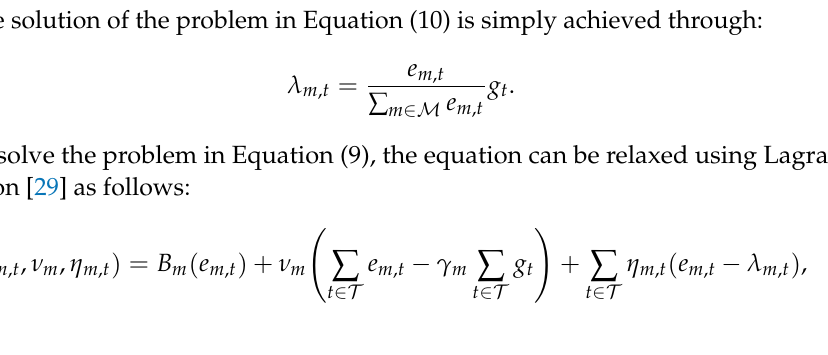
Figure 3. Concept of the proposed community solar operation